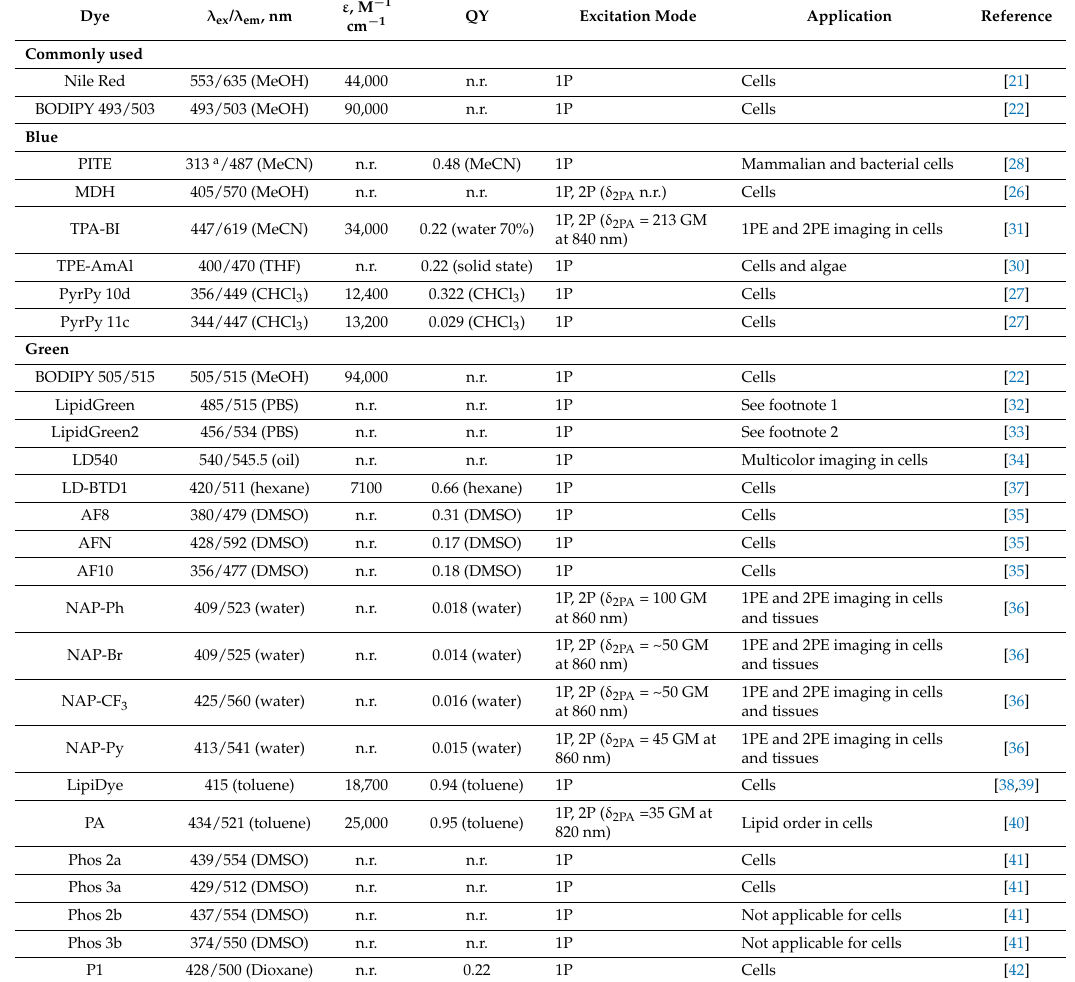
Table 1. Photophysical properties of LDs probes and their